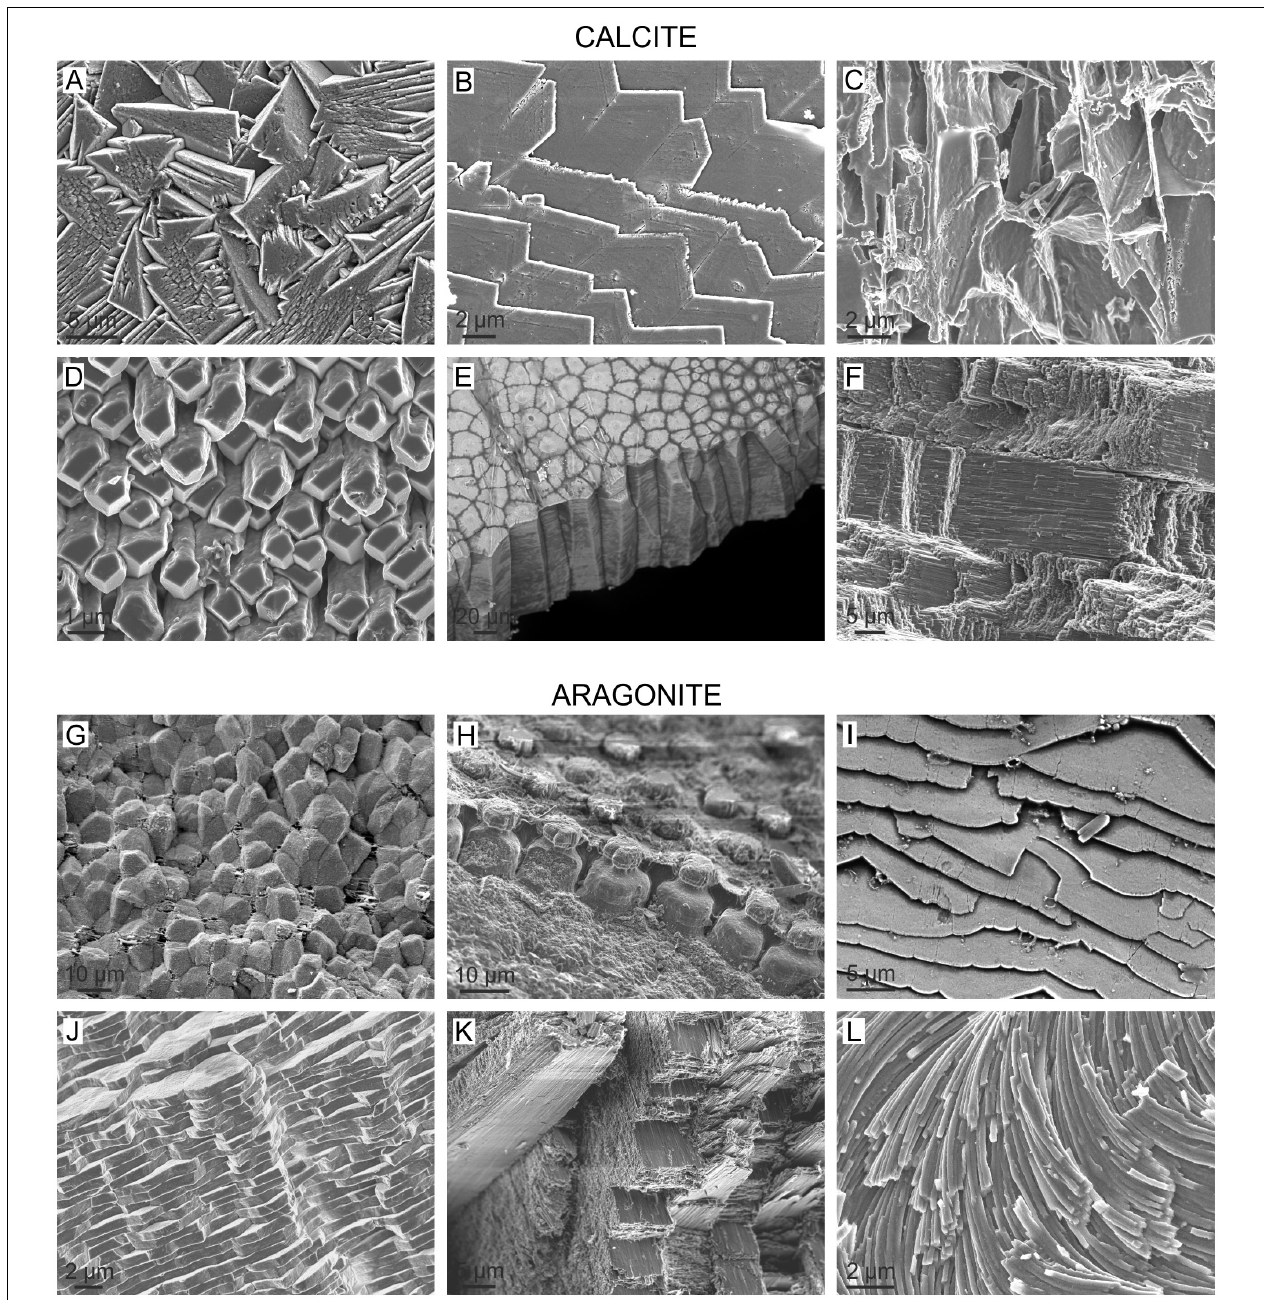
FIGURE 1 | The high diversity of molluscan microstructures, illustrated with selected representative calcitic and aragonitic cases. (A) Granular (rhombohedral) calcite. Outer layer of the patellogastropod Cellana toreuma . (B) Foliated calcite. Bivalve Anomia ephippium . (C) Chalk. Bivalve Crassostrea angulata . (D) Anvil-type fibrous calcite. Outer layer of the bivalve Mytilus chilensis . (E) Columnar prismatic calcite. Outer layer of the bivalve Pinctada margaritifera . (F) Crossed-foliated. Middle layer of the patellogastropod Scutellastra tabularis . (G) Granular prismatic aragonite. Outer layer of the bivalve Entodesma navicula . (H) Columnar prismatic aragonite. Outer layer of the bivalve Neotrigonia lamarckii . (I) Foliated aragonite. Inner layer of the monoplacophoran Rokopella euglypta . (J) Nacre. Internal layer of the bivalve Neotrigonia bednalli . (K) Crossed lamellar. Internal layer of the caenogastropod Semicassis granulata . (L) Helical fibrous aragonite. Opisthobranch gastropod Cuvierina columnella